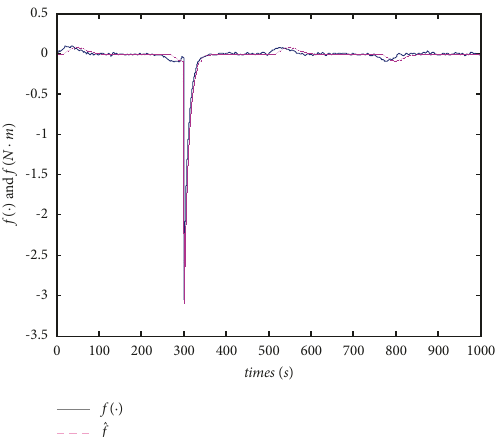
Figure 5: The results of approximation of RBF neural network in the experiment.